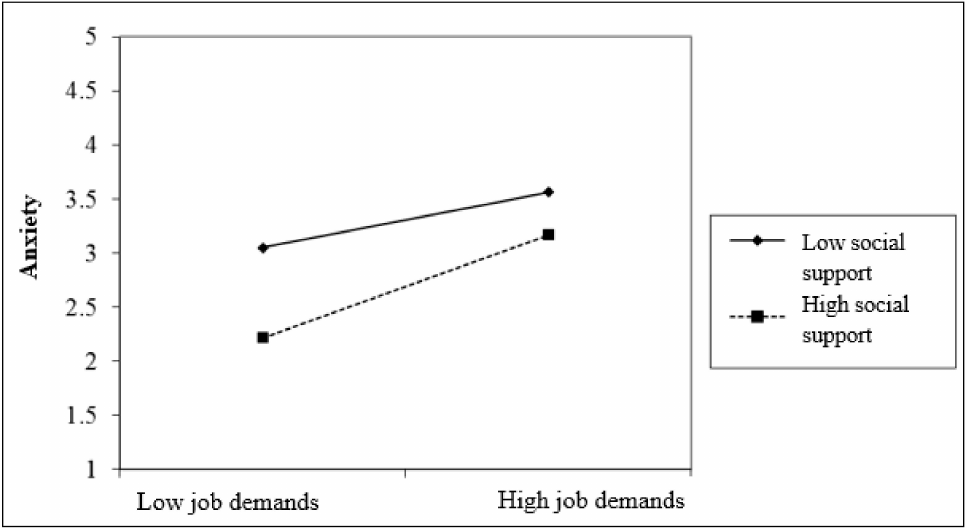
Figure 2. Two-way interaction of job demands and social support in predicting